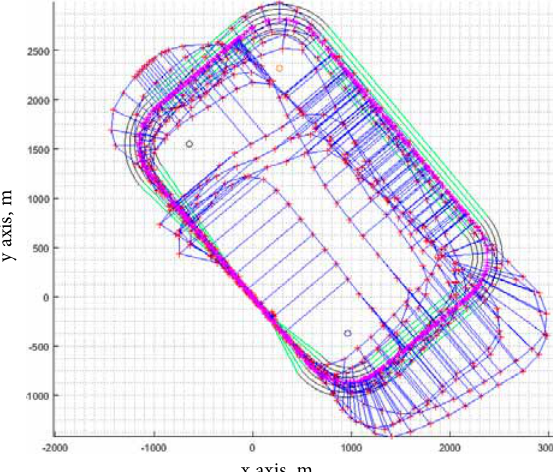
Fig. 10. Flight deviation from the defined traffic circuit